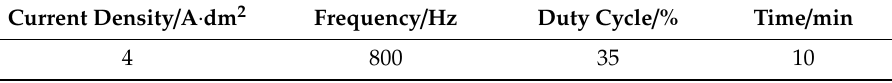
Table 2. Electrical